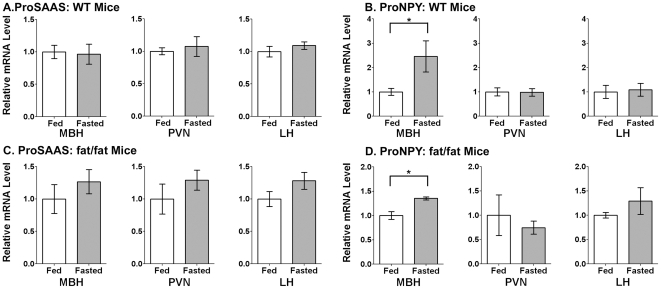
Comparison of proSAAS mRNA and proNPY mRNA levels in fed and fasted mice in various subhypothalamic brain regions.A. ProSAAS mRNA levels do not show a significant change in fasted WT mice relative to mice fed ad libitum in any of the brain regions examined. B. ProNPY mRNA levels increase significantly in the MBH of fasted mice relative to fed mice, but are not affected in the other two brain regions examined. C. ProSAAS mRNA levels do not show a significant change with fasting in subhypothalamic brain regions of Cpefat/fat mice. D. ProNPY mRNA is significantly increased in the MBH of fasted Cpefat/fat mice. Error bars show standard error of the mean for n = 8 in WT mice and n = 3 in Cpefat/fat mice. *, p<0.05 using Student's two-tailed t-test.